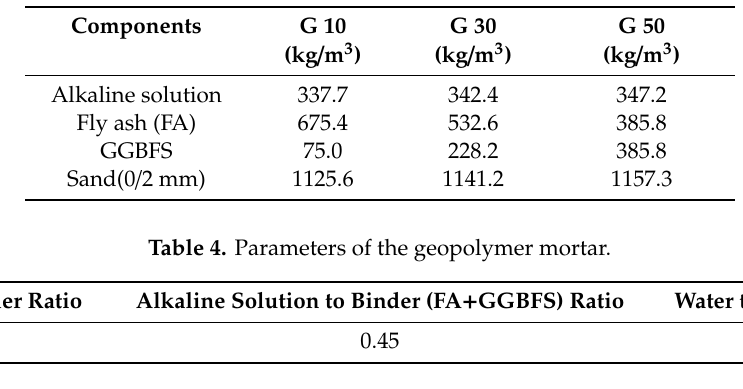
Table 3. Compositions of geopolymer mortar per 1m 3.